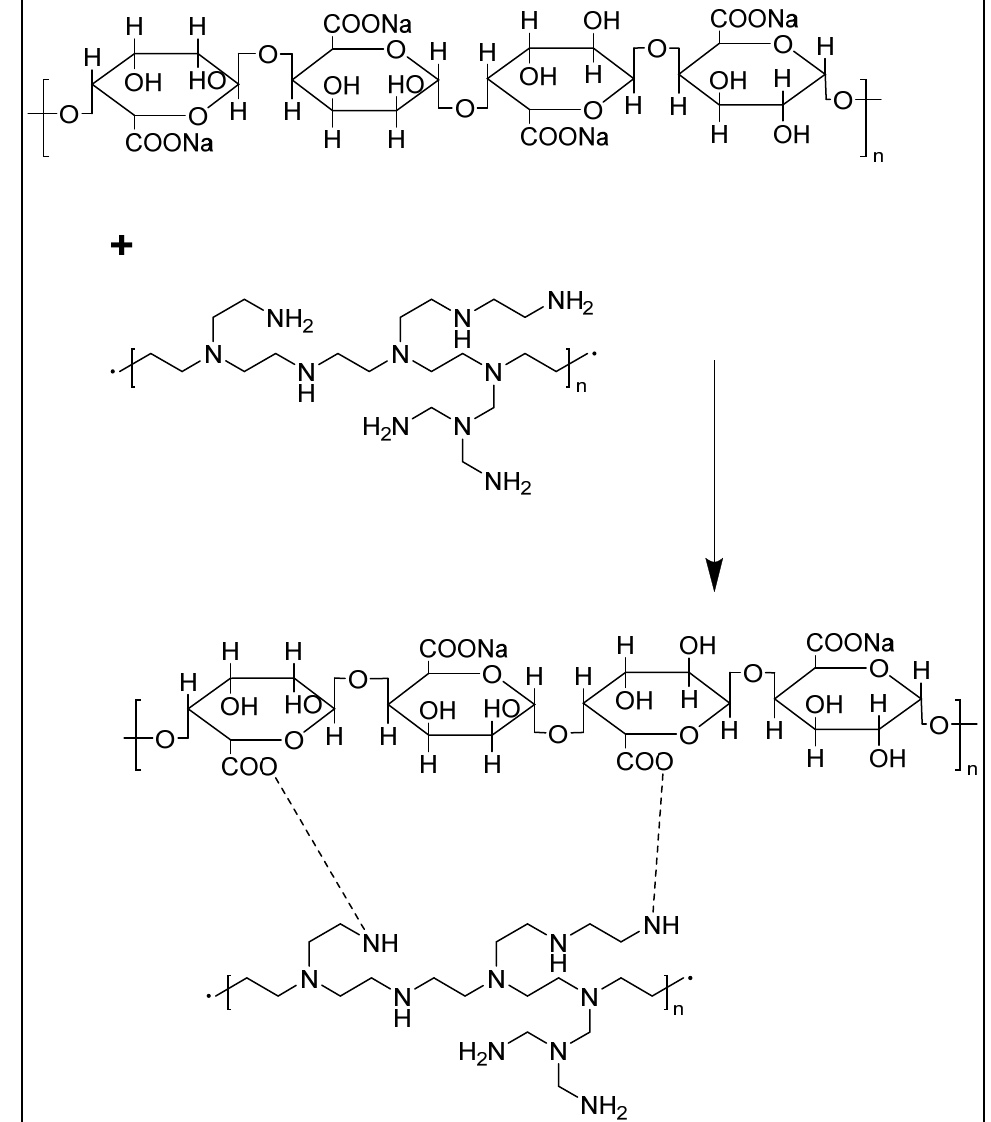
Figure 2. Schematic representation showing the cross-linking of sodium alginate and polyethyleneimine.